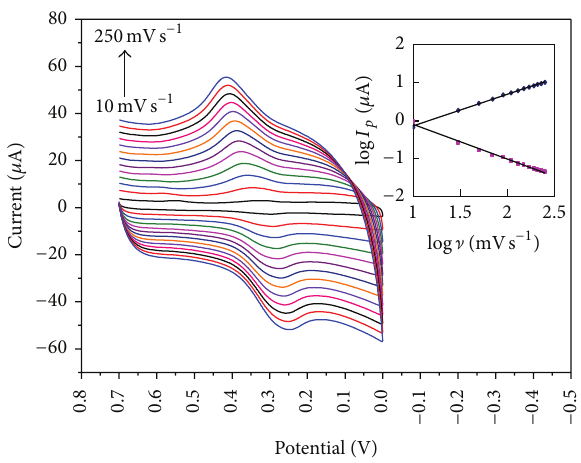
Figure 7: CVs of PDDA-G/GCE in the presence of FA (5.86 × 10 −6 M) at scan rate of 100 mVs −1 with accumulation time varying from 2 min to 30min in pH 3.0 acetate buffer solution. Inset: the relationshipbetweentheanodicpeakcurrentsandtheaccumulation time.